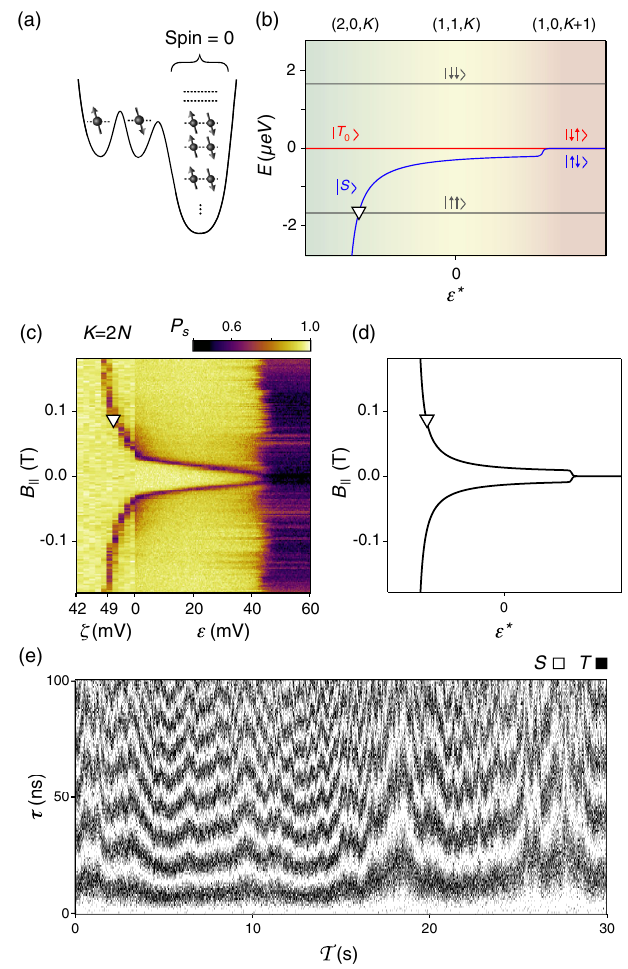
FIG. 3. Spin-0 ground-state behavior of the 2 N occupied multielectron dot. (a) Schematic representation of the electron configuration for even-occupied multielectron dot with spin-0 ground state. Electrons below the Fermi energy in the multi- electron dot are assumed to pair up into spin singlets. (b) Eigen- states of a two-electron triple dot system for fixed applied magnetic field, calculated as a function of ε (cid:2) . For suitable input parameters the resulting spin states (labeled) are a useful model for comparison with experimental data obtained from multi- electron-dot charge states ð 2 ; 0 ; 2 N Þ , ð 1 ; 1 ; 2 N Þ and ð 1 ; 0 ; 2 N þ 1 Þ (see main text). (c) Experimental leakage spectroscopy for K ¼ 2 N , revealing strong exchange coupling in ð 2 ; 0 ; 2 N Þ , i.e., within the double dot, and vanishing exchange interaction in ð 1 ; 0 ; 2 N þ 1 Þ . We associate the sharp feature of suppressed P S (white triangle) with the S − T þ crossing and the overall above ε ≈ 45 mV with S − T 0 oscillations suppression of P S arising from Overhauser gradients. (d) Leakage spectrum ex- pected from the S − T þ crossing within the Hubbard model (white triangle in panel (b)). (e) Time-resolved measurement of coherent oscillations between j S i and j T 0 i two-electron spin states in ð 1 ; 0 ; 2 N þ 1 Þ charge state, for B k ¼ 700 mT and ε ¼ 60 mV. The observed fluctuations of precession frequencies with laboratory time T are characteristic of fluctuating Over- hauser field gradients arising from nuclear spin dynamics within the GaAs